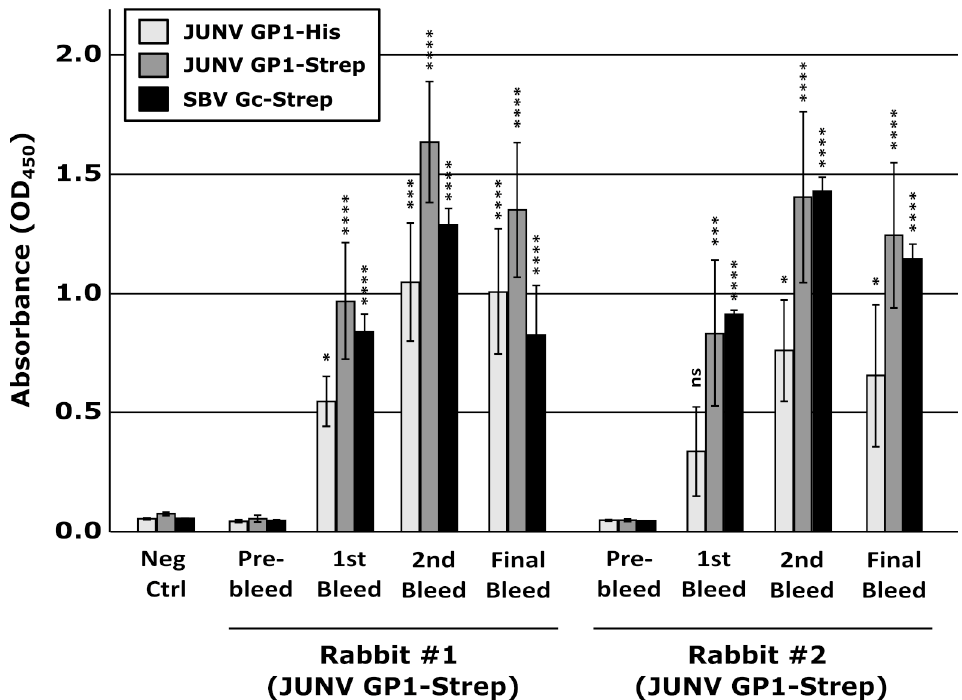
Figure 3. Development of antibodies following vaccination with recombinant Junín virus (JUNV) GP1. Blood samples were collected from rabbits either before immunization or 14 days after each of 3 immunizations with 80 ug of recombinant JUNV GP1-Strep. A sample from another rabbit unrelated to this study served as an additional control (Neg Ctrl). Serum fractions were diluted 1:10 for use in an indirect ELISA assay with JUNV GP1-Strep, JUNV-GP1-His, or Schmallenberg virus Gc amino-Strep (SBV-Gc-Strep) as the target antigen, as indicated. Data from at least two independent experiments are represented and the results of a one-way ANOVA comparing samples post-vaccination to the respective pre-immunization samples are shown (ns not significant; * p ≤ 0.05; *** p ≤ 0.001; **** p ≤ 0.0001).